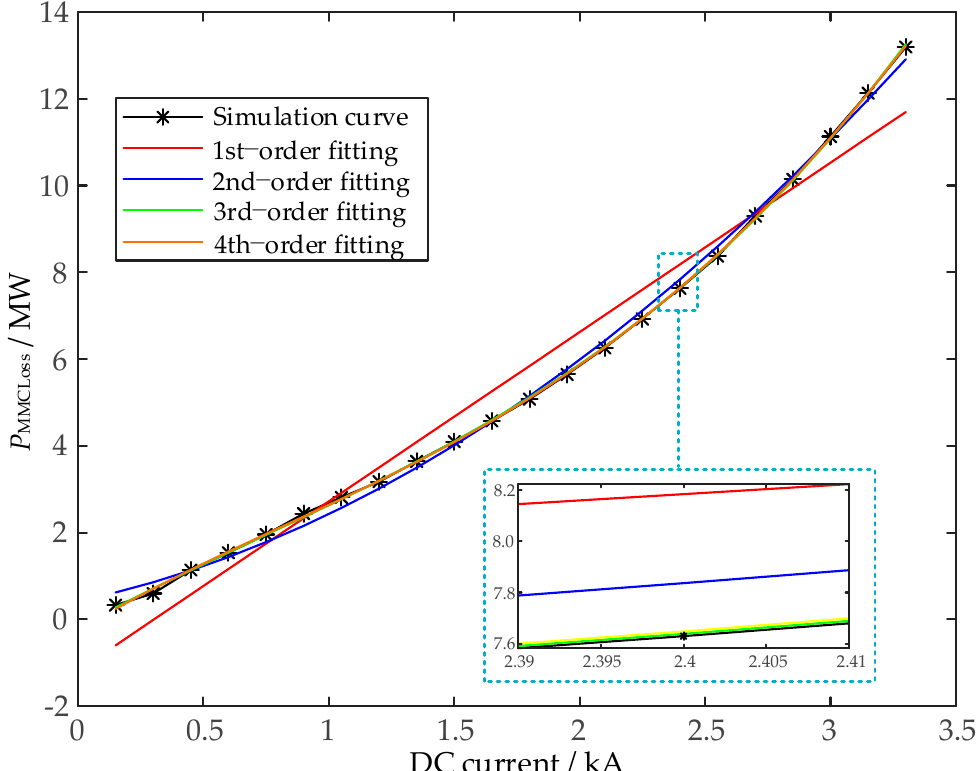
Figure 8. Loss fitting curve of MMC station.